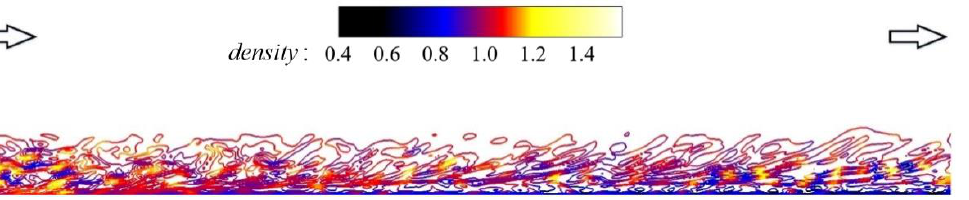
Figure 8. Transient vorticity contours colored by density along the center section in the spanwise direction.